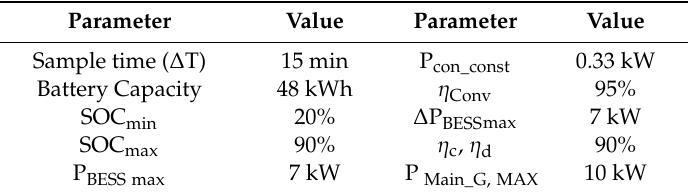
Table 3. Microgrid parameters used in the simulation process.